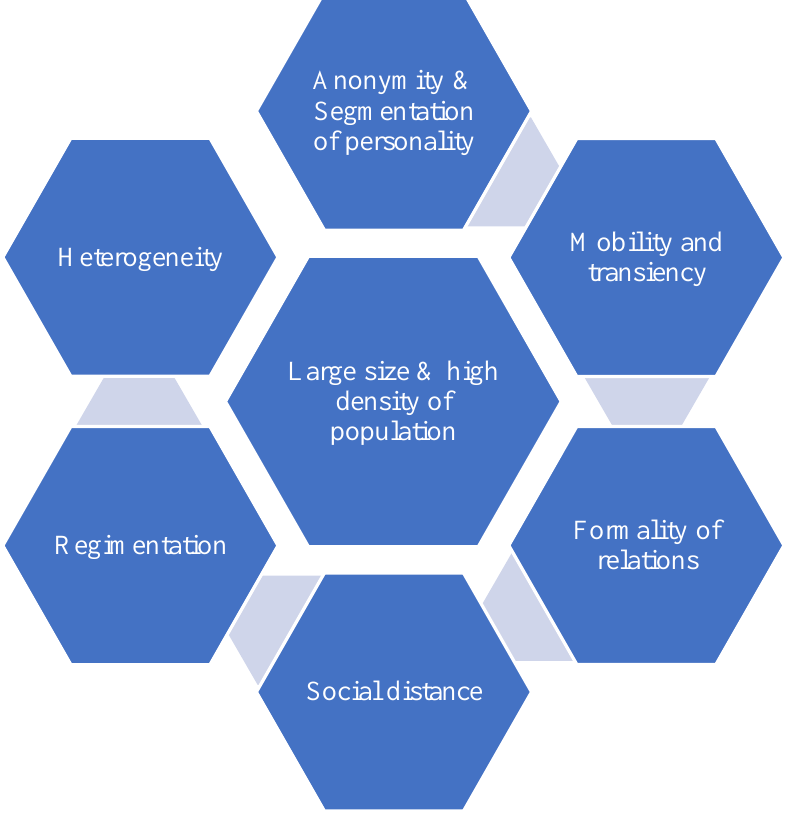
Figure 1. Characteristics of urban spaces. Source: Mondal [6].